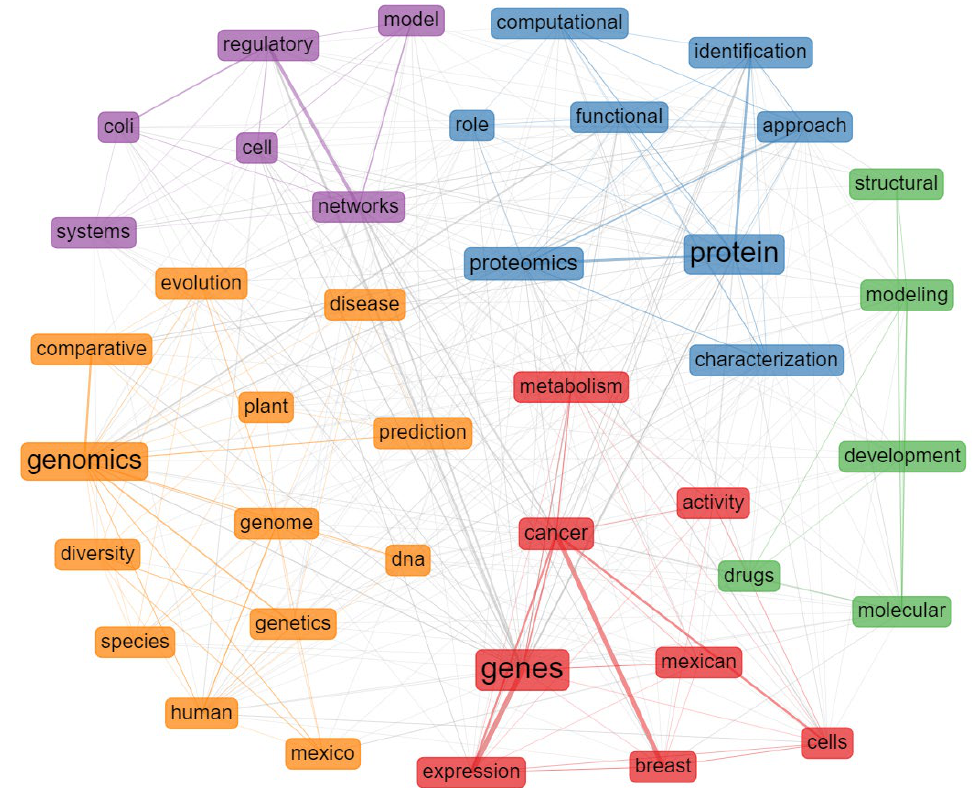
Figure 4. Word co-occurrence network extracted from the titles of the articles associated with Mexican bioinformatics. Clusters in colors are derived from the walk trap algorithm. The word size is proportional to occurrences and the edges to the association strength index between words.